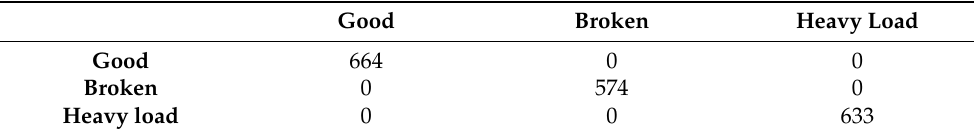
Table 4. Confusion matrix of the generated